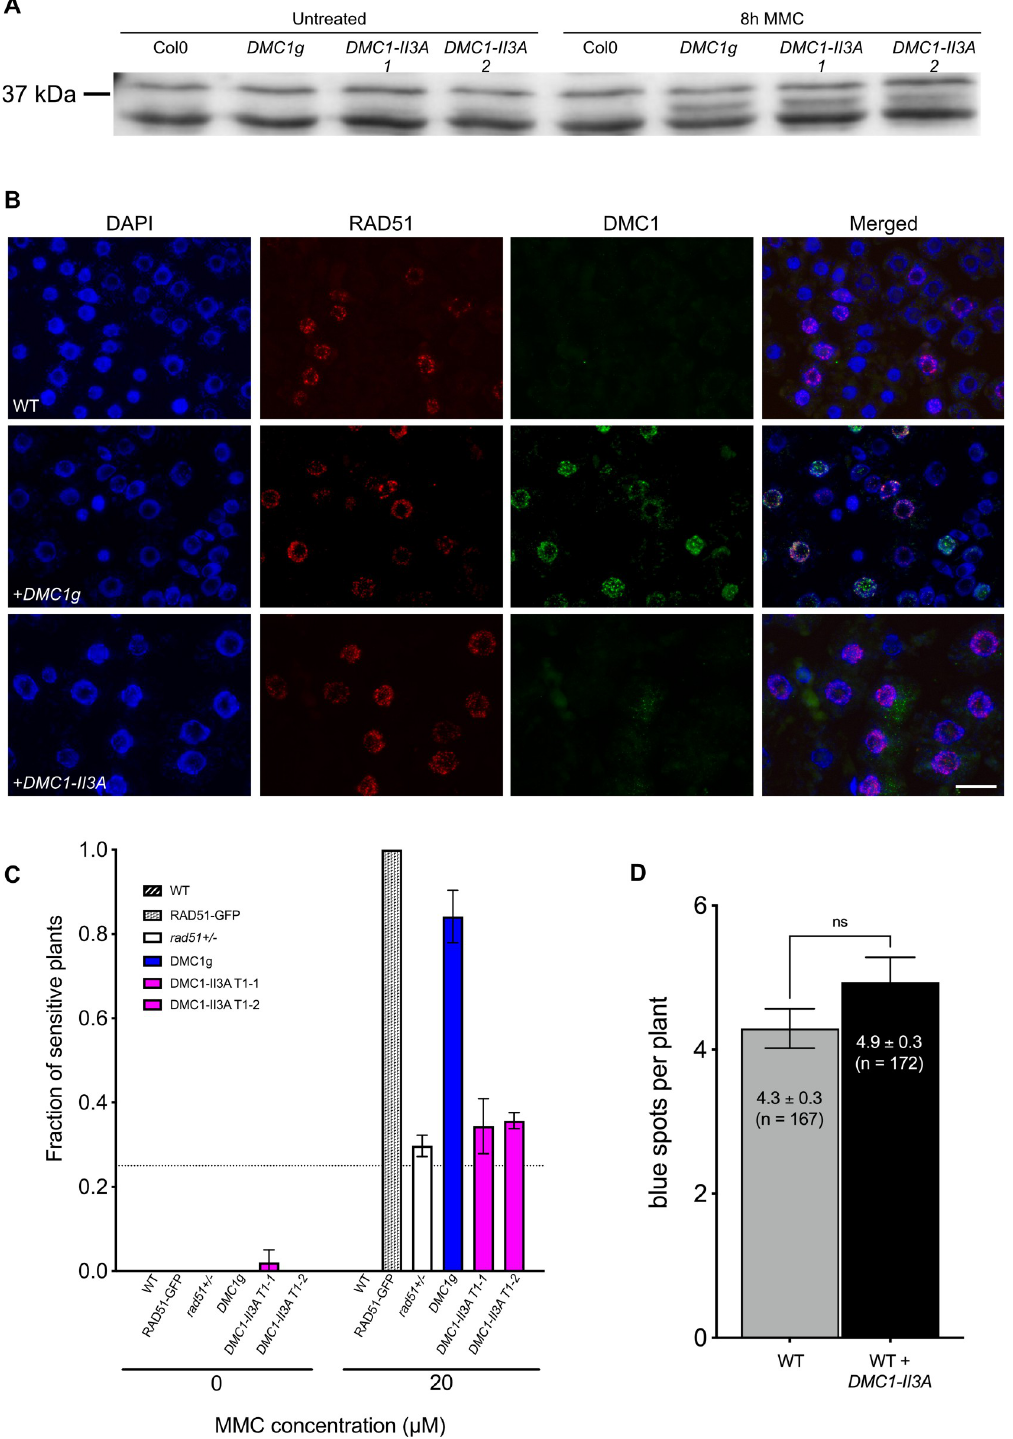
Fig 6. DMC1-II3A variant does not form focus nor prevent RAD51-mediated recombination in somatic cells. (A) DMC1g and DMC1-II3A protein are induced by MMC treatment. Total proteins were extracted from 1-week-old seedlings treated or not with 30 μ M MMC for 8 hours and DMC1 abundance measured. No DMC1-specific band (37 kDa) is observed in untreated plants in both wild-type and transgenic plants. In contrast, while DMC1 is still absent in wild-type plants after DNA damage treatment, it becomes clearly visible in transgenic plants expressing either pDMC1 :: DMC1g or pDMC1 :: DMC1-II3A